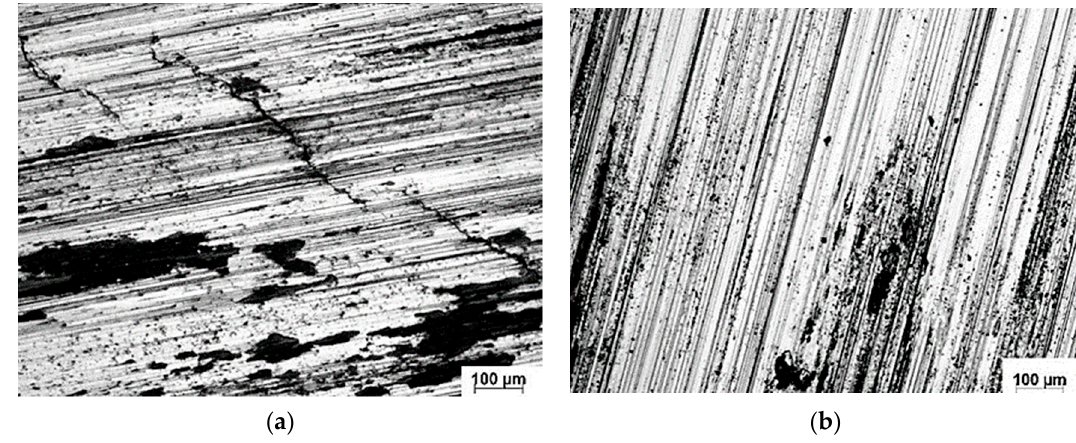
Figure 18. Optical microstructure after wear test of S1 LHT sample at ( a ) 6 J.mm − 2 and ( b ) 16.78 J.mm − 2 .